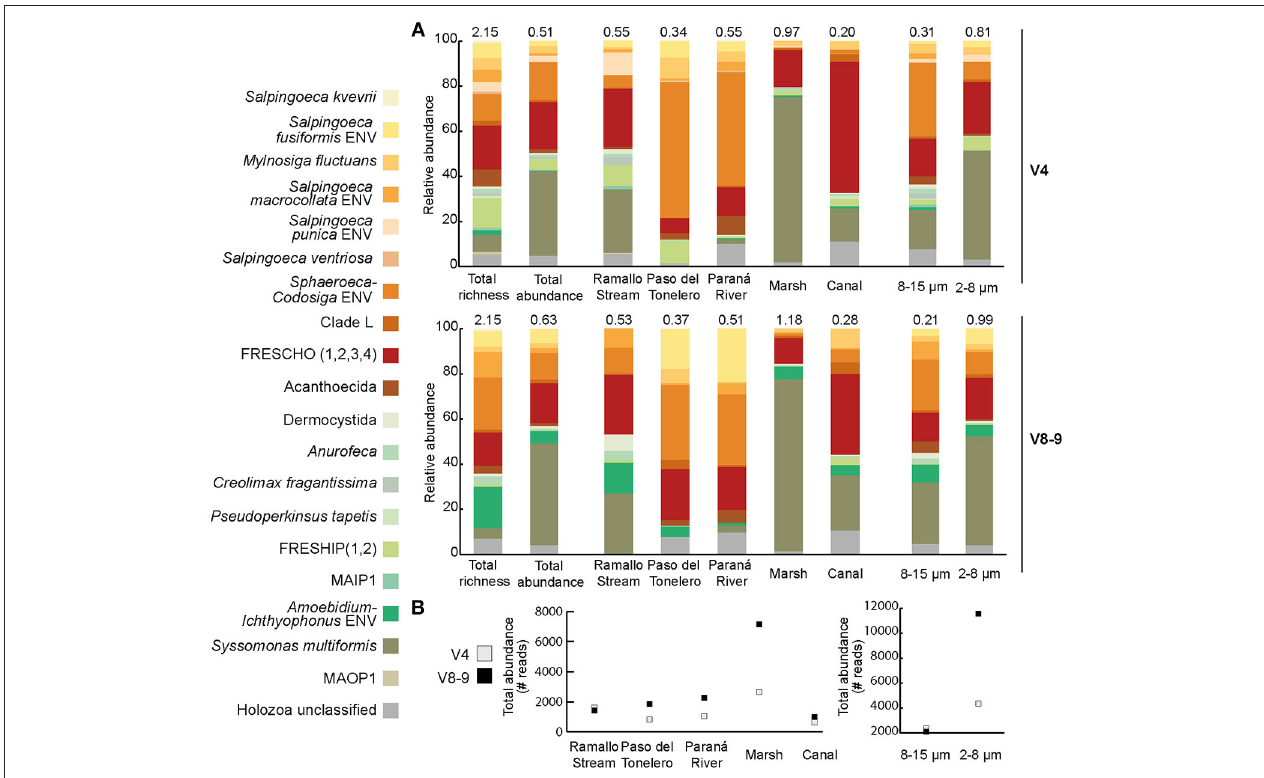
FIGURE 4 | (A) Distribution and relative abundance of the unicellular Holozoa as a whole, across sampling sites and by size fraction. Note that Syssomonas multiformis , Sphaeroeca-Codosiga environmental clade and the environmental group freshwater choanoflagellates (FRESCHO) account for most of the detected diversity. Numbers on top of each histogram shows the relative proportion of the unicellular Holozoa with respect to all eukaryotes. ENV stands for environmental, those sequences in our dataset that expand the diversity of a specific clade or species. (B) Distribution of reads across sampling sites (left) and size fraction (right) depending on the 18S region considered. Even though the diversity patters are similar, the V8-9 region detects more abundance in each sampling site, especially in the 2–8 µ m